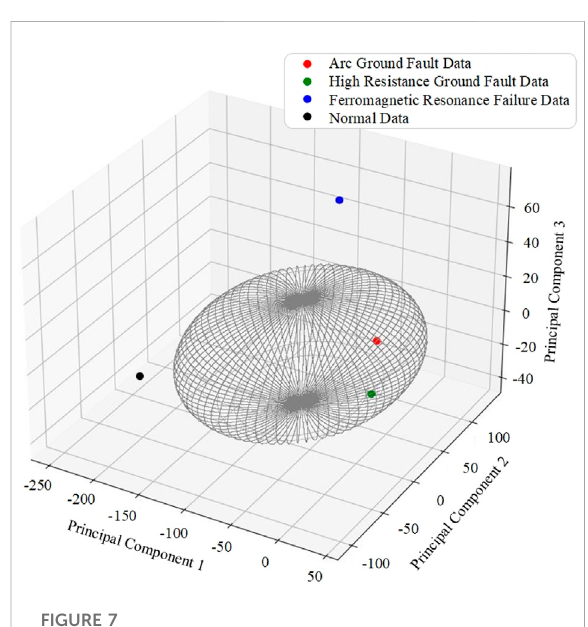
FIGURE 7 Therelativepositionsofthefourtypesofsampledataandthe security